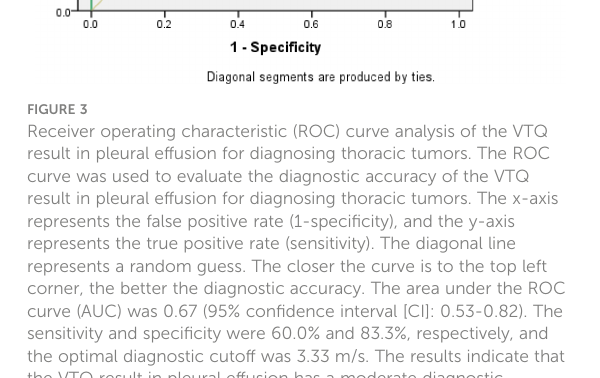
The ROC curve analysis of CXCL13 showed an AUC of 0.74 (0.61, 0.86) with an optimal cut-off value of 777.82 pg/ml, indicating that the test has moderate accuracy for diagnosing lung tumors. The ROC curve analysis of VTQ showed an AUC of 0.67 (0.53, 0.82) with a sensitivity of 60.0% and a speci fi city of 83.3%, which suggests that the test has limited accuracy for diagnosing lung tumors. The combination of CXCL13 and VTQ for diagnosing thoracic tumors had an AUC of 0.842 (0.74, 0.94), which was signi fi cantly